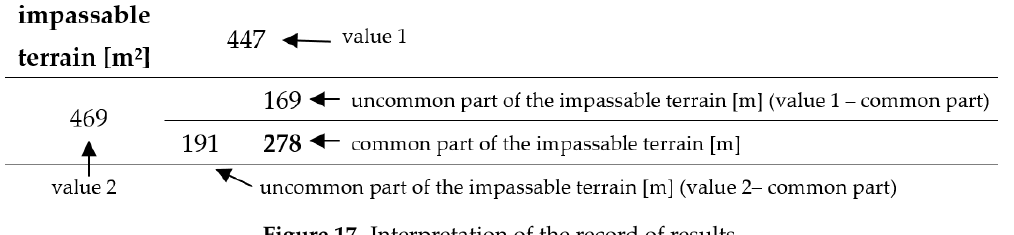
Figure 17. Interpretation of the record of results.